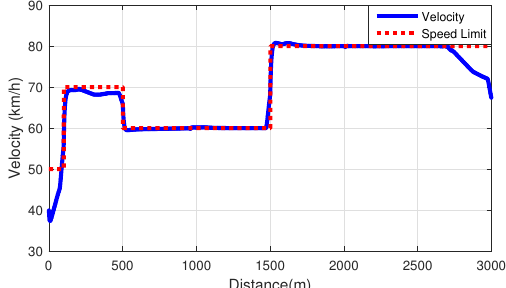
Figure 11. Velocity of the simulated vehicles.